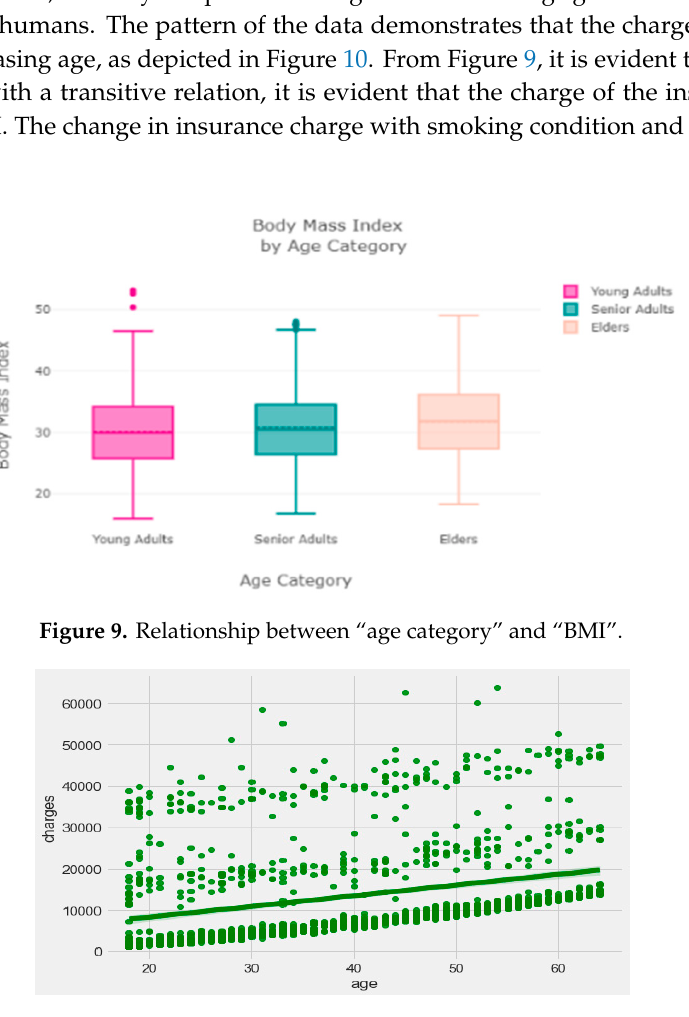
Figure 10. Relationship between “age category” and “charges”.